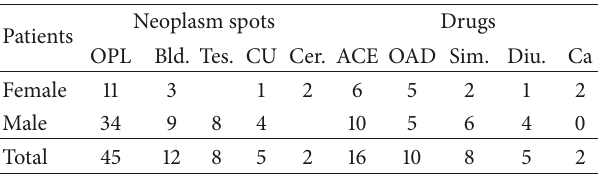
Table 3: Distribution of hearing loss over haplogroups (%) ( 𝑝 = 0.796